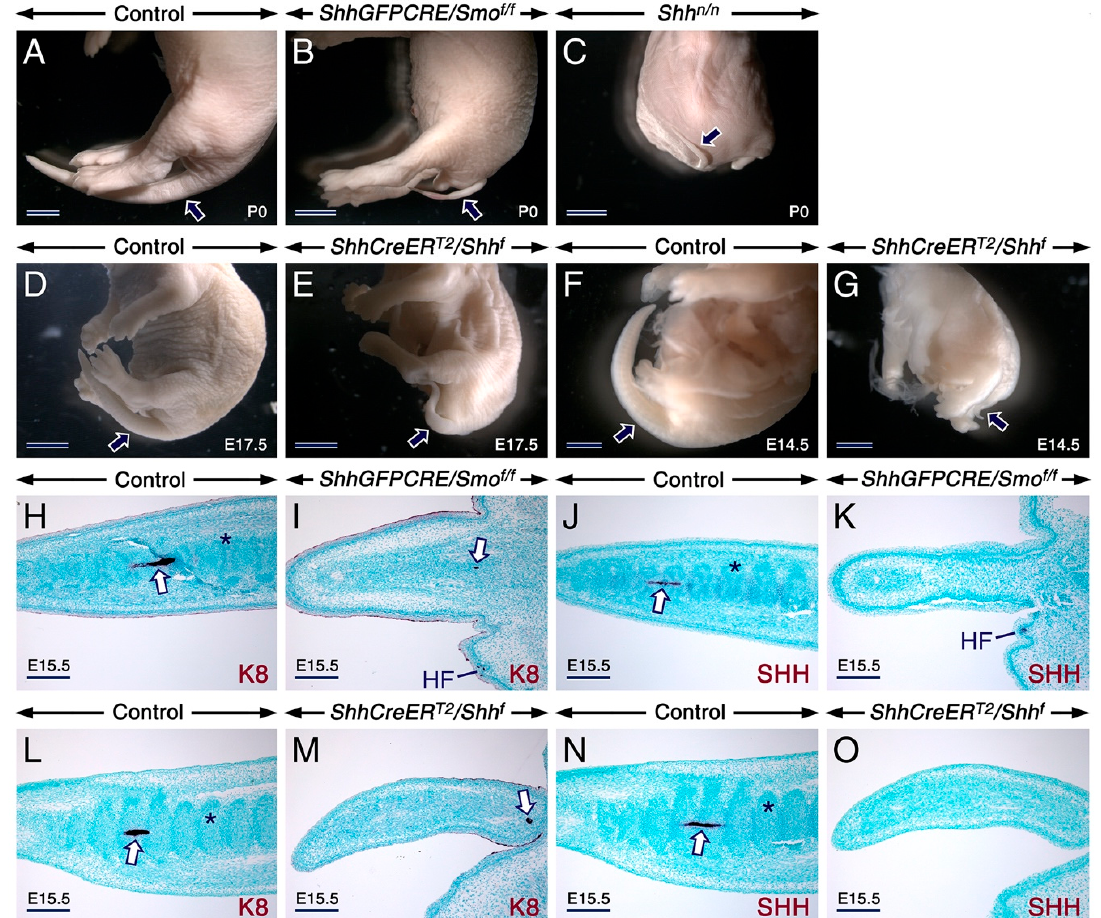
Figure 1. Loss of sonic hedgehog (SHH) signaling generates an abnormally thin and truncated tail lacking the notochord and vertebral chondrogenic condensations. ( A – G ). Representative external tail phenotype (arrows) of mutants relative to controls. Control ( A ; n = 15), ShhGFPCRE / Smo f / f mutant ( B ; n = 11), and Shh n / n mutant ( C ; n = 2) newborns (P0). E17.5 control ( D ; n = 8) and ShhCreER T2 / Shh f mutant ( E ; n = 9) embryos first exposed to tamoxifen (TAM) at E11.5. E14.5 control ( F ; n = 5) and ShhCreER T2 / Shh f mutant ( G ; n = 6) embryos first exposed to TAM at E10.5. The mutants exhibit severe tail defects. ( H – O ) Tail sections from E15.5 mutants and controls immunostained (dark purple) for Keratin 8 (K8) and Sonic hedgehog (SHH) to visualize the notochord. Tails from a control embryo ( H , J ) and a ShhGFPCRE / Smo f / f embryo ( I , K ). Tails from a control embryo ( L , N ) and a ShhCreER T2 / Shh f mutant embryo ( M , O ) first exposed to TAM at E10.5. The control tails display chondrogenic mesenchymal condensations of presumptive vertebrae (asterisks) and a notochord (arrows) in the caudal region, whereas the mutant tails lack these structures. K8-positive (arrows in I and M ) remnants of the notochord are visible in the rostral region of the mutant tails. HF, hair follicle. Scale bars: 2 mm ( A – C ), 1 mm ( D – G ) and 200 µm ( H – O ).